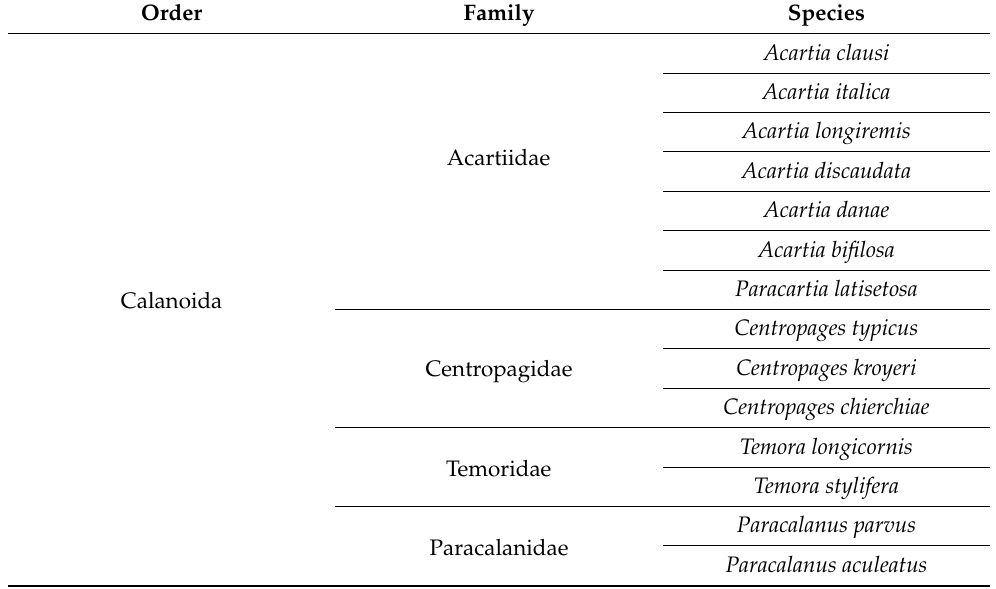
Table 3. Species composition of Copepoda collected in 15 stations in the Gulf of Gabès. Taxa with an heterogeneous composition (e.g. nauplii, copepodids, adults) are not indicated